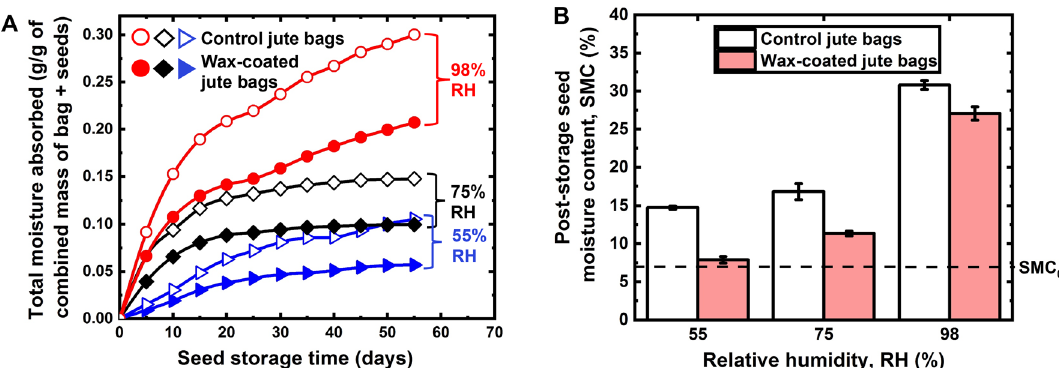
Figure 4. Moisture absorption through jute bags and the moisture content of wheat grains after 2 months of storage. ( A ) Total moisture absorbed through control jute bags (CJBs: unfilled shapes) and wax-coated jute bags (WCJBs: filled shapes) over the seed-storage period. Total moisture absorbed was taken as the sum of moisture uptake by jute bags and stored grains; the combined mean mass of the storage bag plus seed was ~ 170 g/bag. ( B ) Post-storage seed moisture content (SMC) of stored wheat grains at different relative humidity (RH) conditions. Horizontally-dotted line (SMC